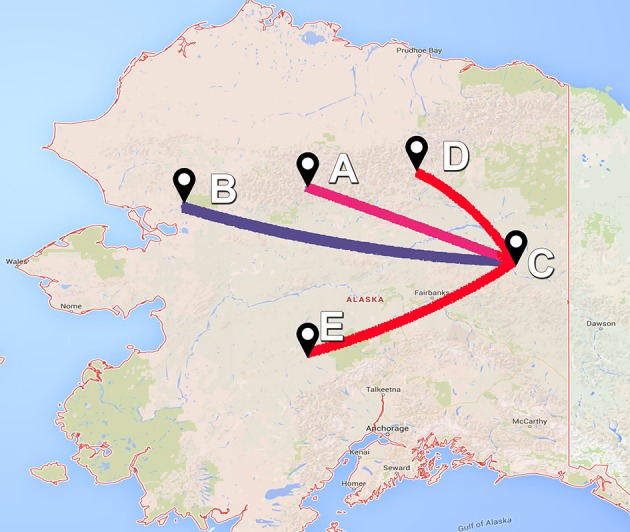
Bayes factor (BF) test for significant non-zero rates in ORF5 gene of Porcine Reproductive and Respiratory Syndrome Virus RFLP type 1-7-4 cluster in the United States. Only rates supported by a BF greater than six are indicated. The color of lines correspond to the probability of the inferred transmission rates. Blue and red line gradients indicate relatively weak to strong support, respectively. Site locations for the five systems (A–E) were anonymous and therefore latitude and longitude locations were placed in Alaska.